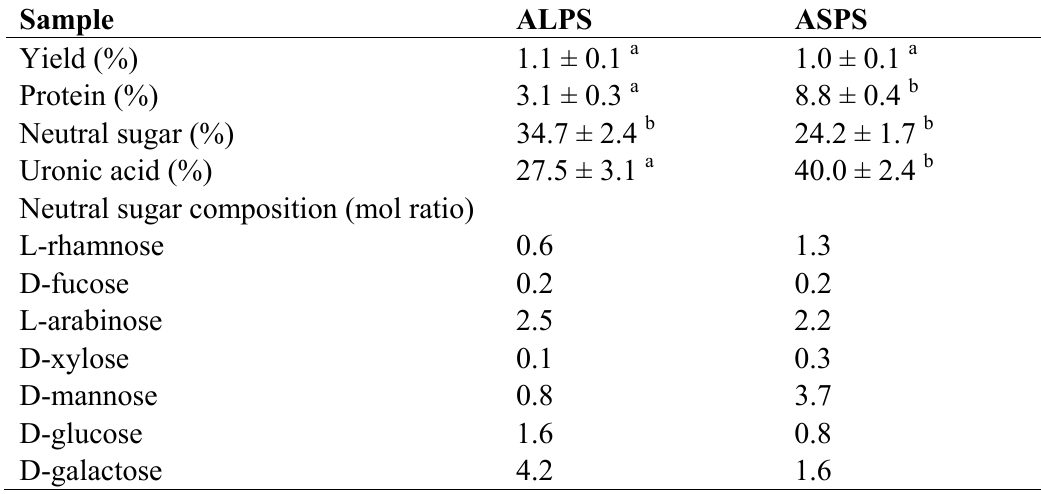
Table 1. Chemical composition of ALPS and